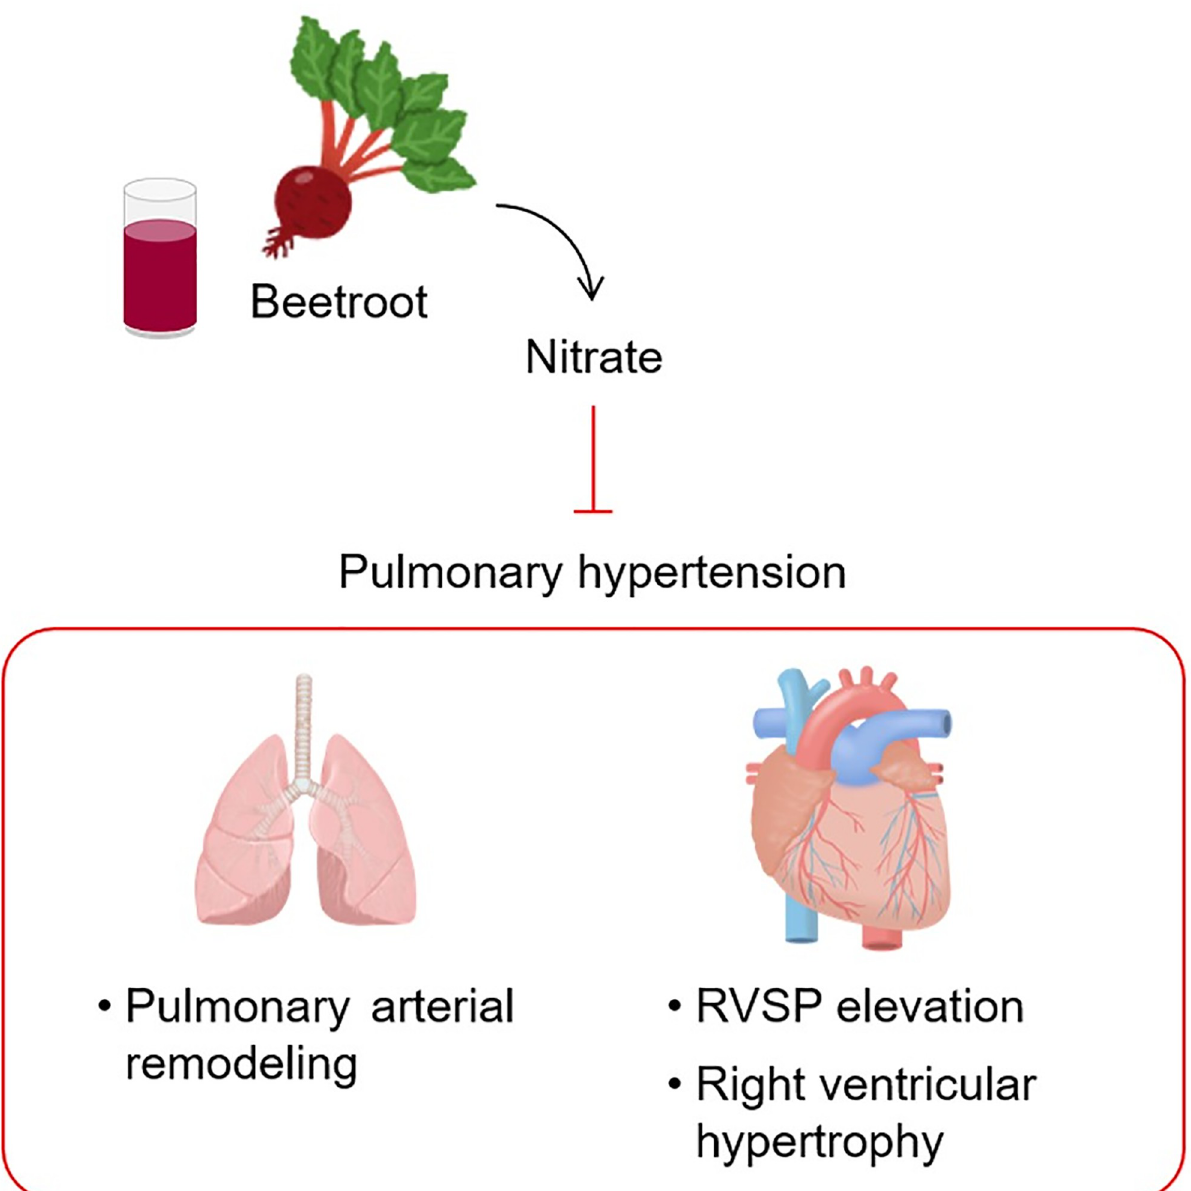
Fig 5. Schematic representation of BJ-induced beneficial effects on PH. Abbreviations: BJ, beetroot juice; PH, pulmonary hypertension; RVSP, right ventricular systolic pressure.